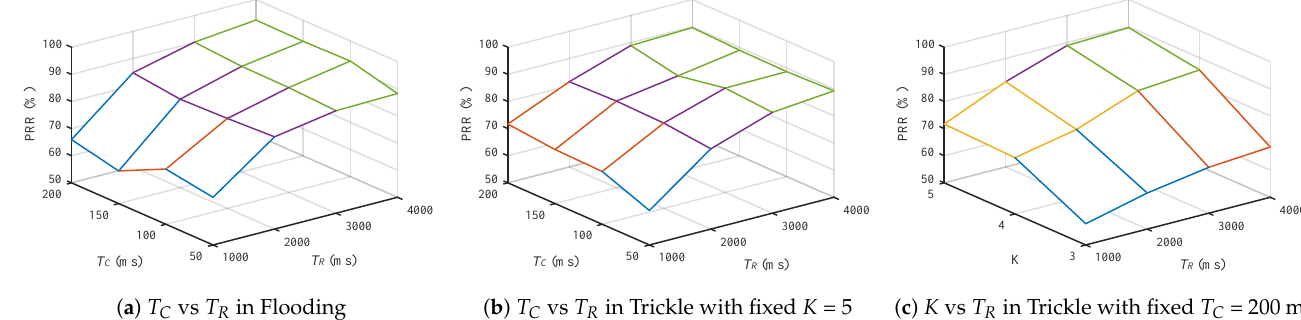
Figure 6. A 3D plots representing Packet Reception Ratio with varying parameters.